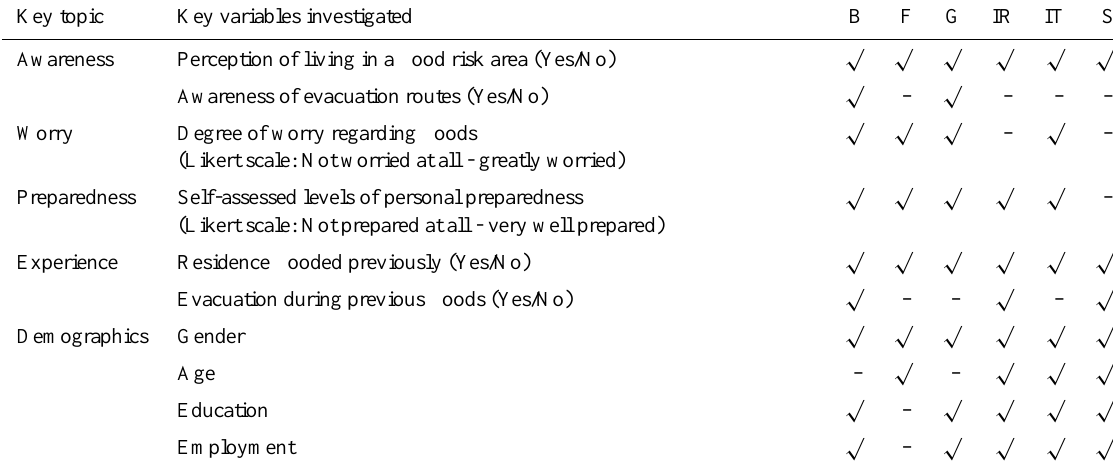
Table 3. Key variables investigated in questionnaires in Belgium (B), Finland (F), Germany (G), Ireland (IR), Italy (IT) and Scotland (S). Key topic